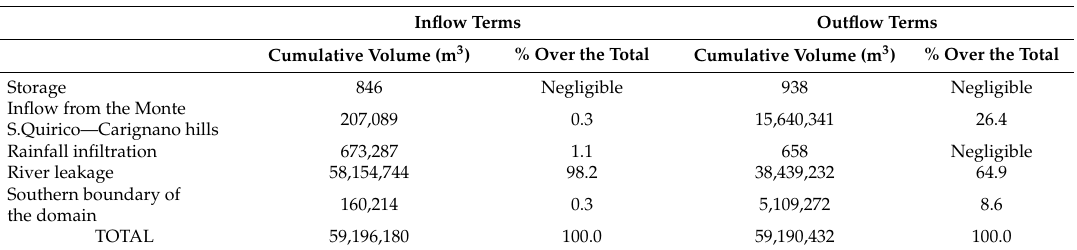
Table 1. Simulated water budget for the Sant’Alessio aquifer for the hydrologic year October 2015 to September